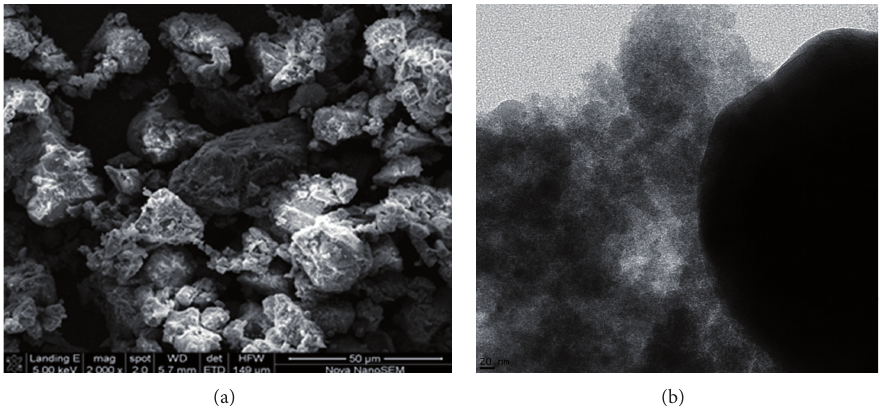
F 8: (a) ��� of activated carbon-�y ash-n�iO